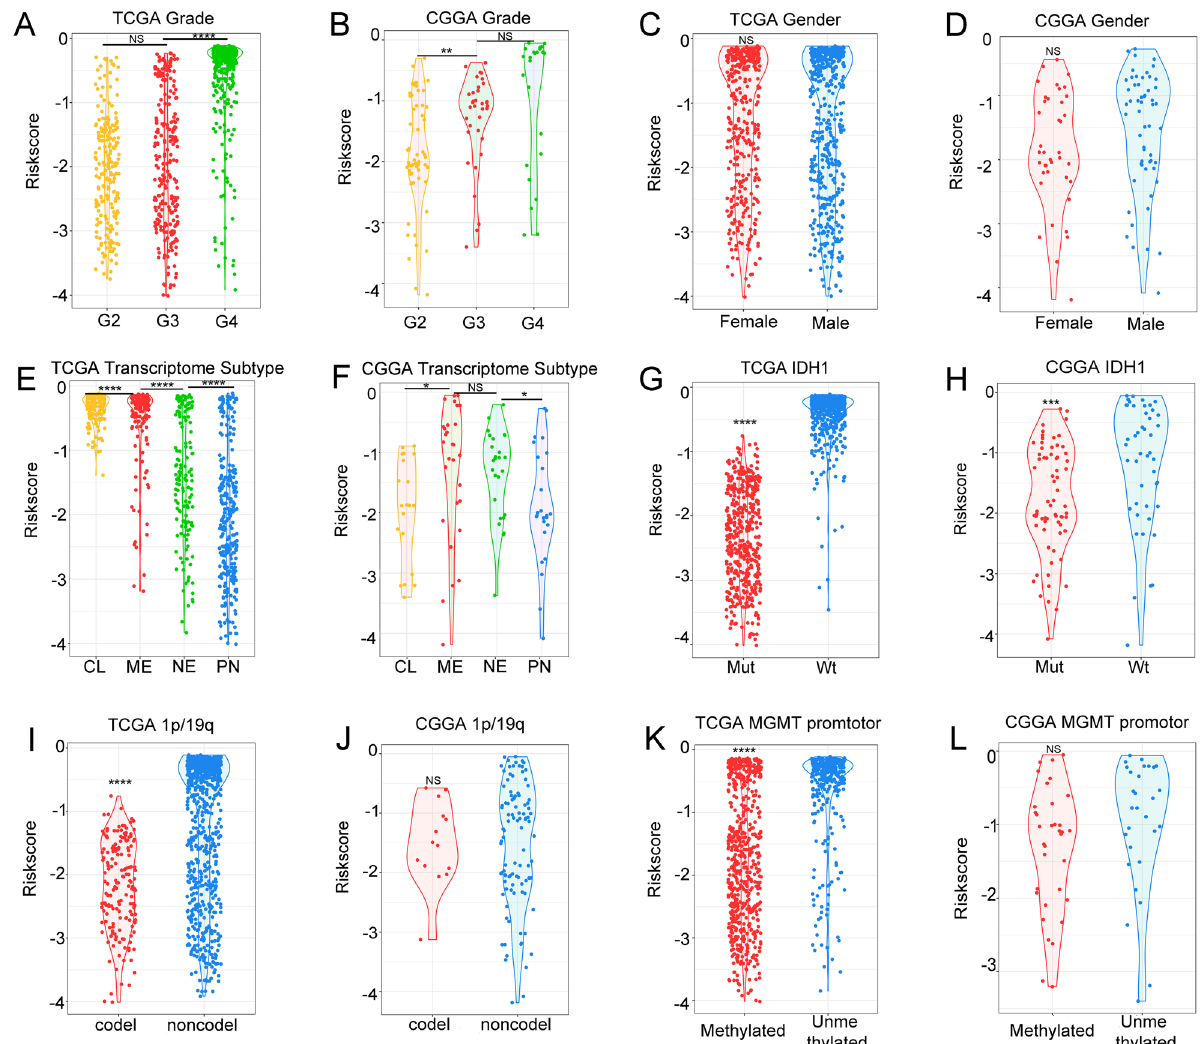
Figure 3. Correlations between risk scores and clinical features in the TCGA and CGGA databases. ( A , B ) Correlation between risk score and WHO grade in the TCGA and CGGA databases. ( C , D ) Correlation between risk score and gender in the TCGA and CGGA databases ( CL classical, ME mesenchymal, NE neural, PN proneural). ( E , F ) Correlation between risk score and transcriptome subtype in the TCGA and CGGA databases. ( G , H ) Correlation between risk score and IDH1 status in the TCGA and CGGA databases. ( I , J ) Correlation between risk score and 1p/19q status in the TCGA and CGGA databases. ( K , L ) Correlation between risk score and MGMT promoter status in the TCGA and CGGA